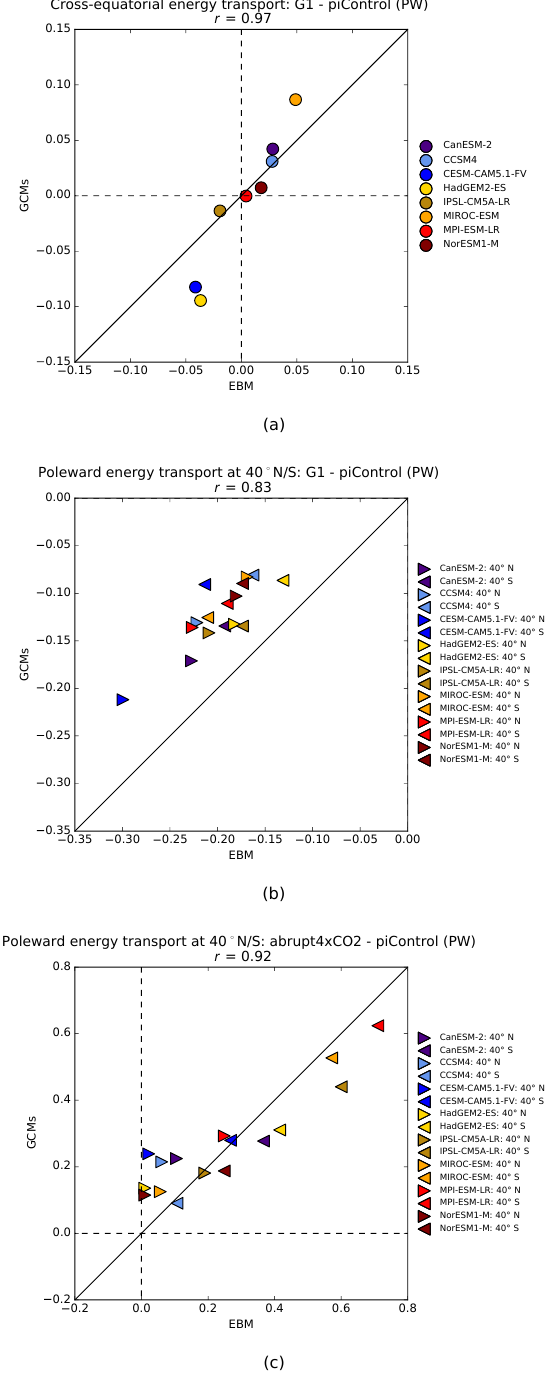
Figure 5. Meridional energy transport changes calculated by moist EBM ( x axis) versus those diagnosed from the GCM output ( y axis). (a) Northward energy transport across the Equator, for G1 – piControl; (b) poleward energy transport changes across 40 ◦ N and S, for G1 – piControl; (c) same as in (b) but for abrupt4xCO2 – piControl. Diagonal solid lines are 1 : 1